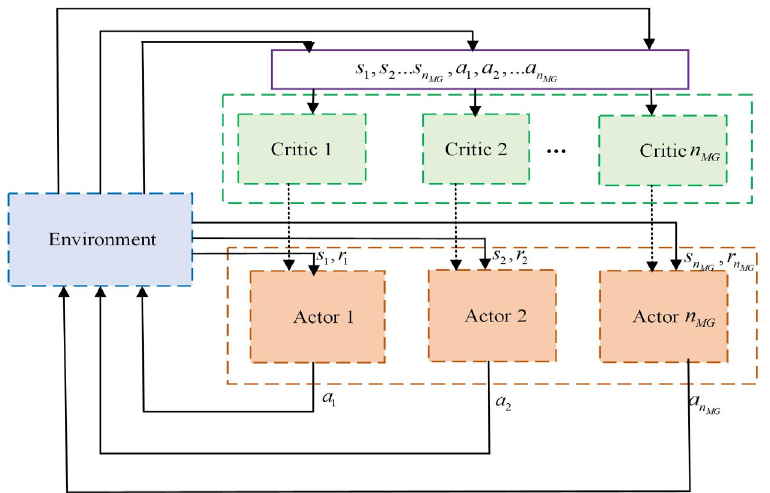
Figure 4. The CTDE structure diagram.